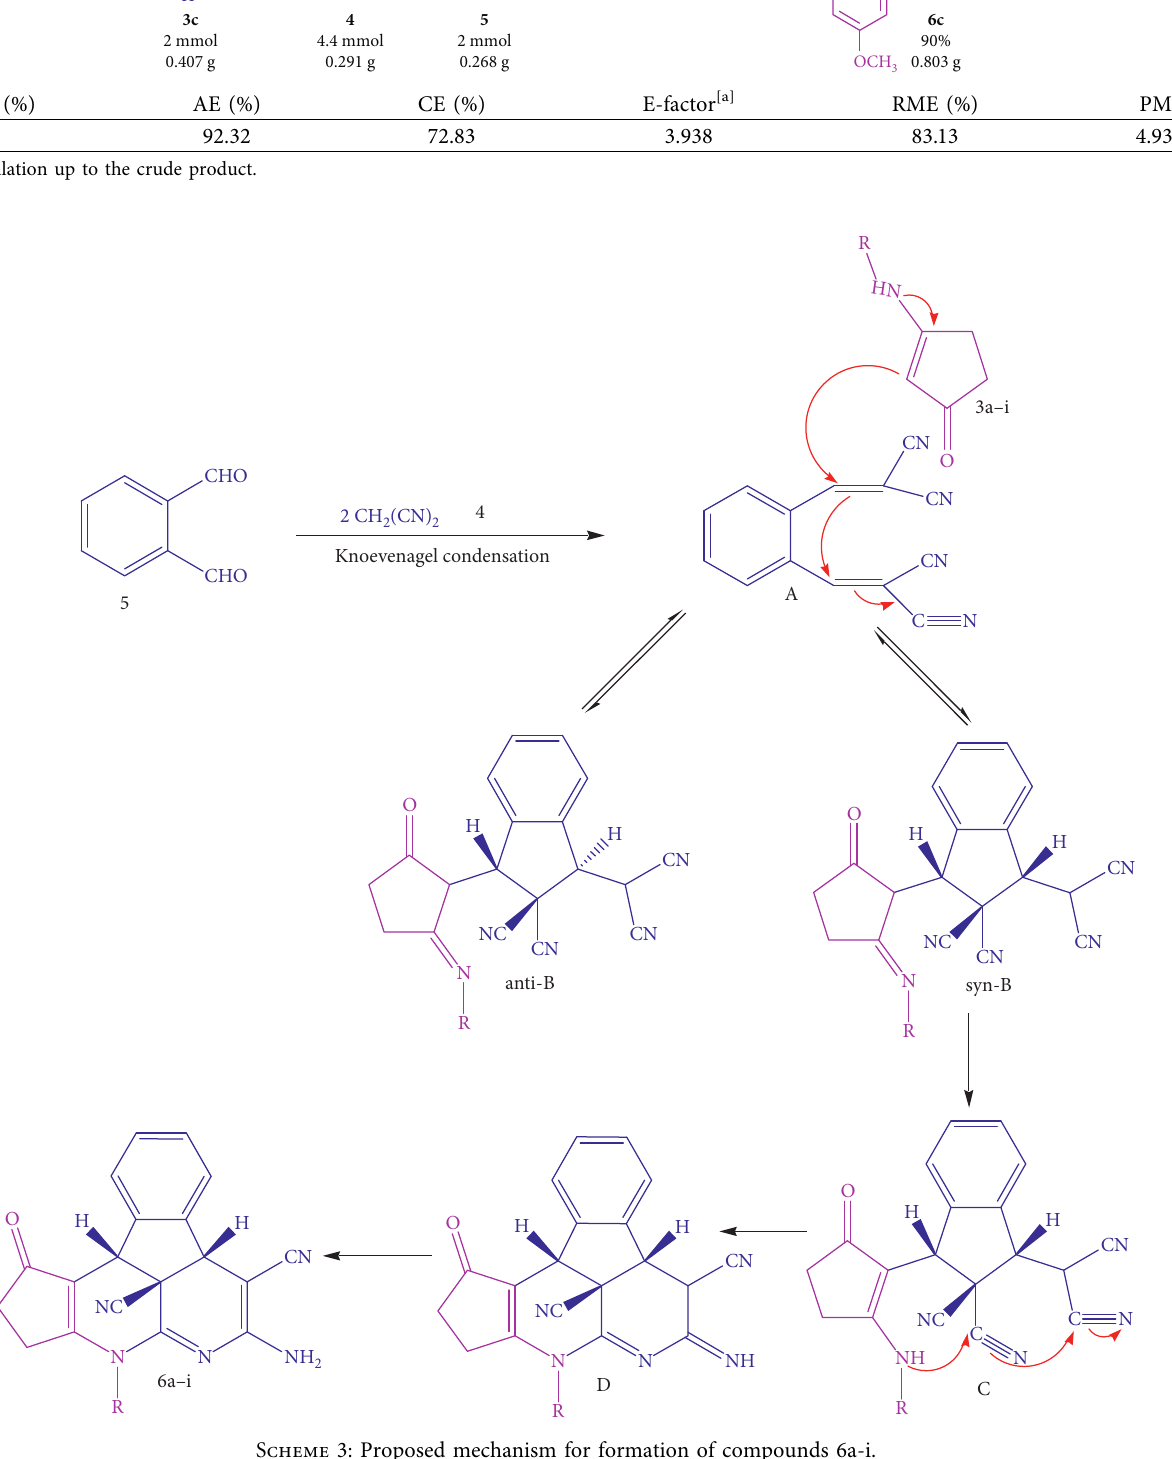
Scheme 3: Proposed mechanism for formation of compounds 6a-i.